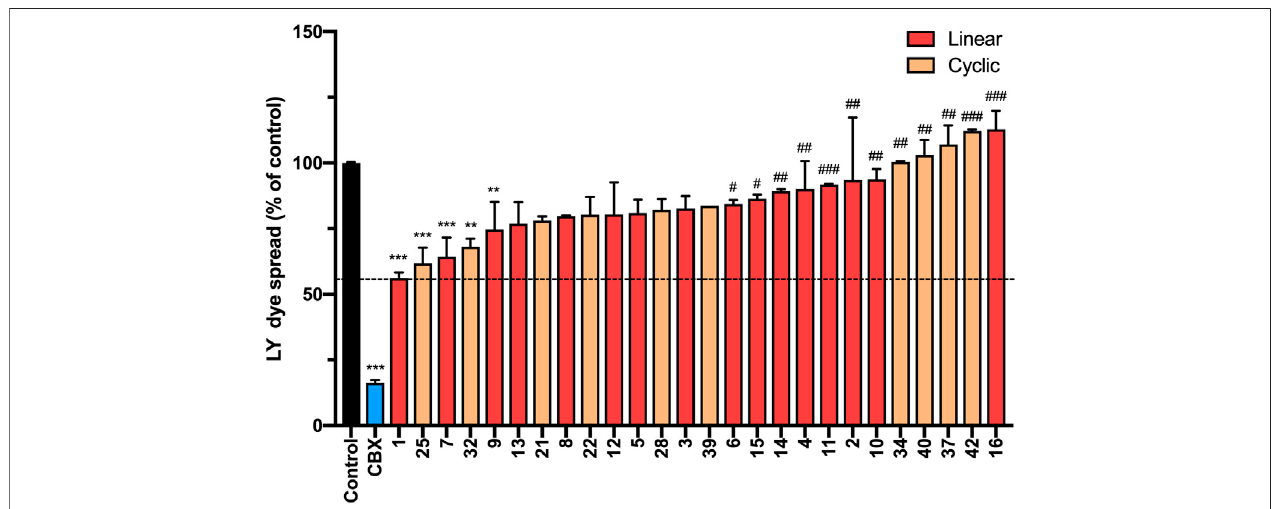
FIGURE 12 | N -terminal, C-terminal, and cyclic modi fi cations affect peptide5 (1) function against gap junctional coupling in hCMVEC cells in vitro . Positive LY dye transfer between coupled gap junction channels is represented as a percentage of the untreated control. LY dye transfer was signi fi cantly reduced compared to untreatedcontrolfollowingtreatmentwithCbxorpeptide5( 1 )(**** p < 0.0001).Thepeptidessubstitutedwithan N -methyllysine( 7 )or D -lysine( 9 )preventedthespreadof LY toa level comparable to peptide5 (1)(** p < 0.01, *** p < 0.001, respectively). A number ofmodi fi ed peptides demonstrated alevel ofLYdyetransfer signi fi cantly greaterthanpeptide5andnotdifferentfromcontrol,indicatingcompletelossoffunctionofthesepeptides, # p < 0.05.Thecyclicpeptides 25 and 32 signi fi cantlyreduced LYtransfercomparedtocontrolbutnotpeptide5** p < 0.01,*** p < 0.001.Thecyclicpeptides 40 , 34 ,and 42 demonstratedalevelofLYdyetransfersigni fi cantlygreater than peptide5 and not different from control, indicating loss of function of these peptides, ### p < 0.001, #### p < 0.0001. All values represent the mean, SEM. One-way ANOVA, Dunnett ’ s comparison test against control (*) or peptide5 (#).